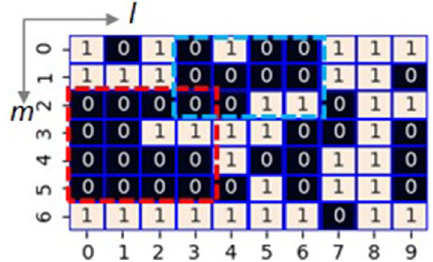
Figure 1. A model of electoral districts with 70 cells arranged in a 7 × 10 rectangle (Case 1) where 1(0) means a cell that Party A(B) has an advantage over B(A). Party A controls 35 cells, whereas Party B controls the remaining 35 cells. Red or blue dotted rectangle designates the areas where Party B has a significant